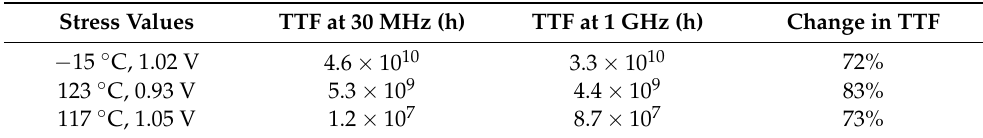
Figure 1. Three TTF-to-frequency plots. The TTF decreases with the increase in stress. The decrease in TTF with frequency is similar across all the tests, showing a decrease in TTF to about 75%. Table 1. A table showing the relative change in TTF with frequency for three stress modes. The TTF at 1 GHz is about 75% compared to the TTF values at 30 MHz.